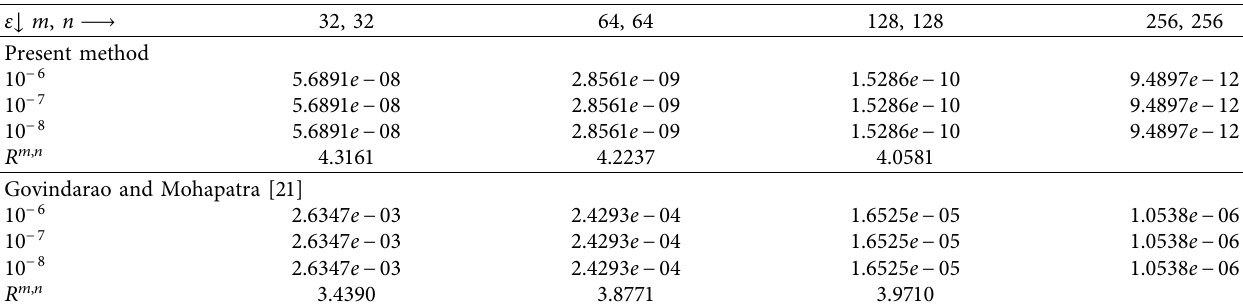
Table 4: Comparison of absolute maximum errors and rate of convergence R m,n for Example 2. ε ↓ m , n ⟶